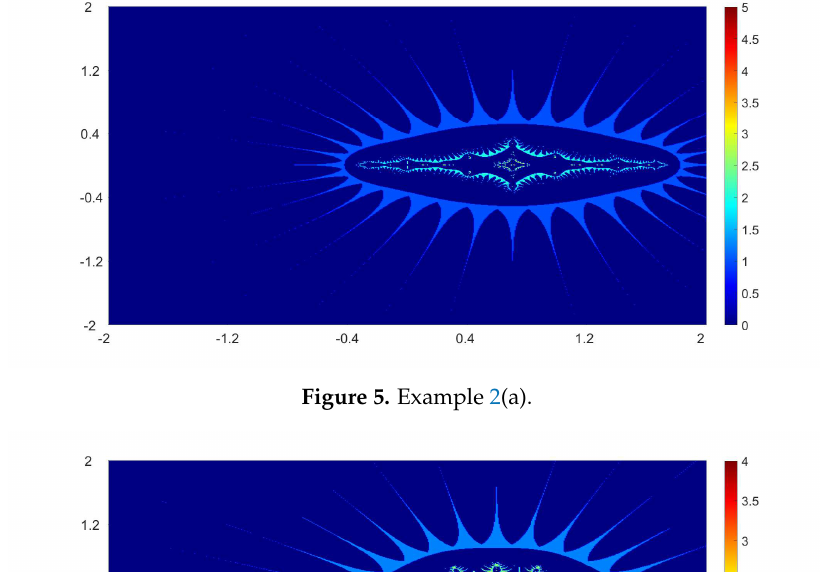
Figure 5. Example 2(a).